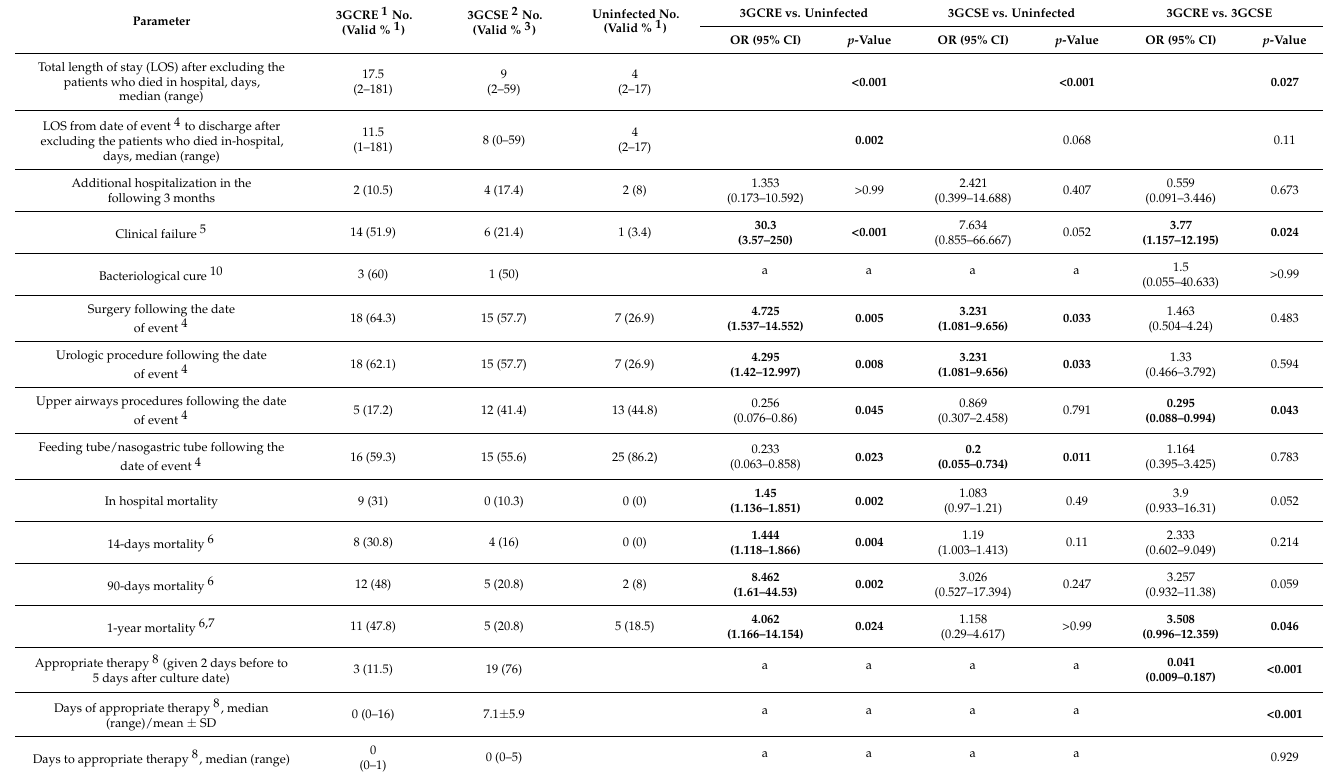
Table 2. Selected bivariable analyses comparing outcomes of patients with 3GCRE infection, patients with 3GCSE infections, and uninfected control patients ( n = 29 in each